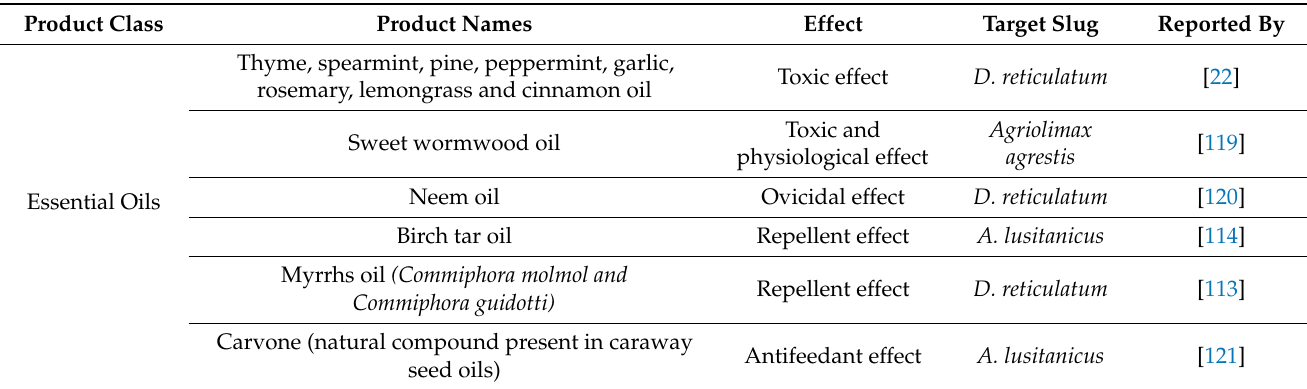
Table 4. List of natural products showing toxic, physiological, ovicidal, repellent and antifeedant effects against slugs. Product